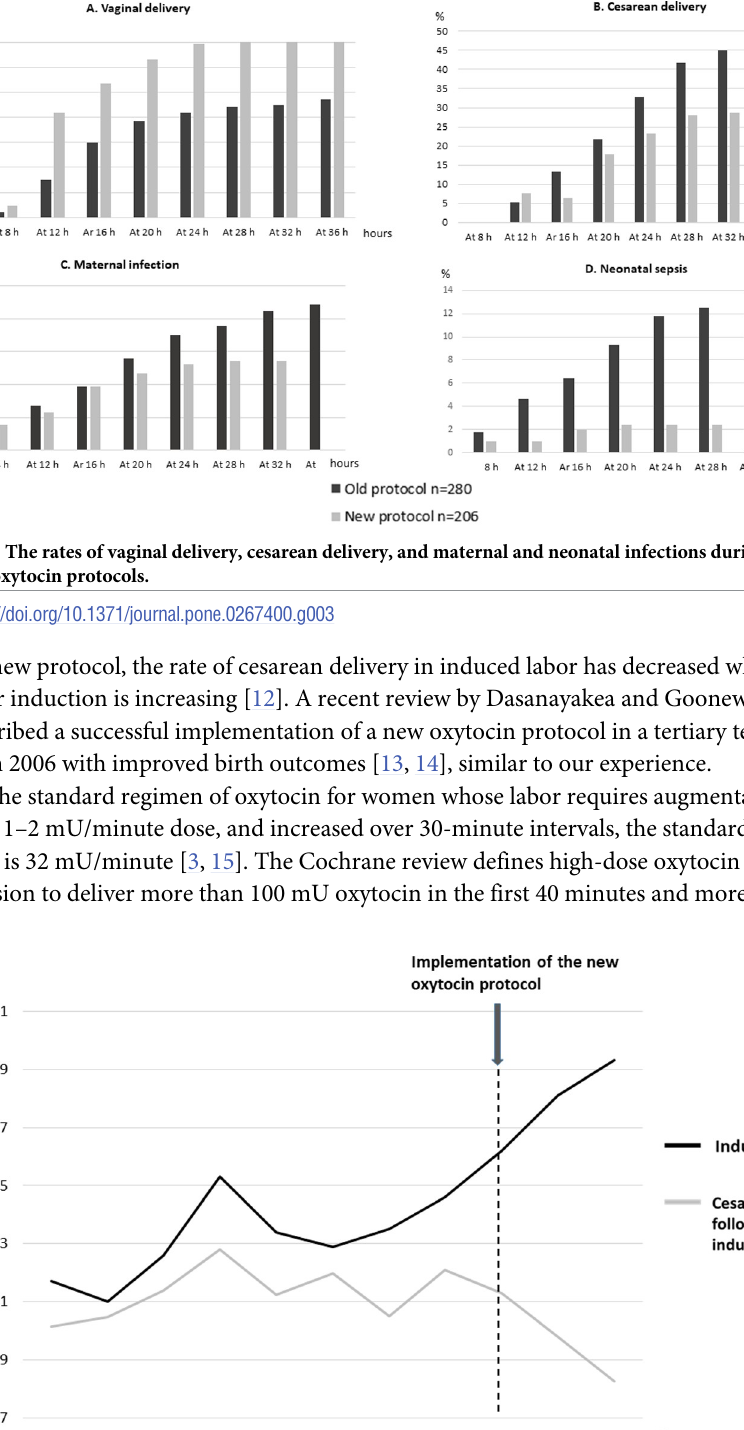
PLOS ONE | https://doi.org/10.1371/journal.pone.0267400 April 22,